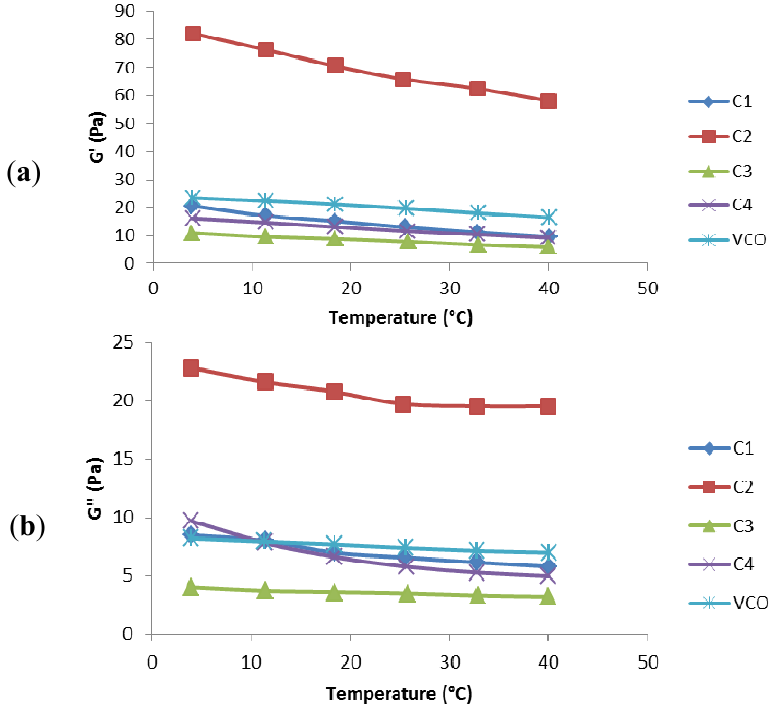
Figure 3. ( a ) Storage modulus G' (Pa) vs. temperature sweep (°C), ( b ) loss modulus G'' (Pa) vs. temperature sweep (°C), and ( c ) viscosity η (Pa.s) vs. temperature sweep (°C) data for commercial emulsion samples (C1, C2, C3, C4) and virgin coconut oil